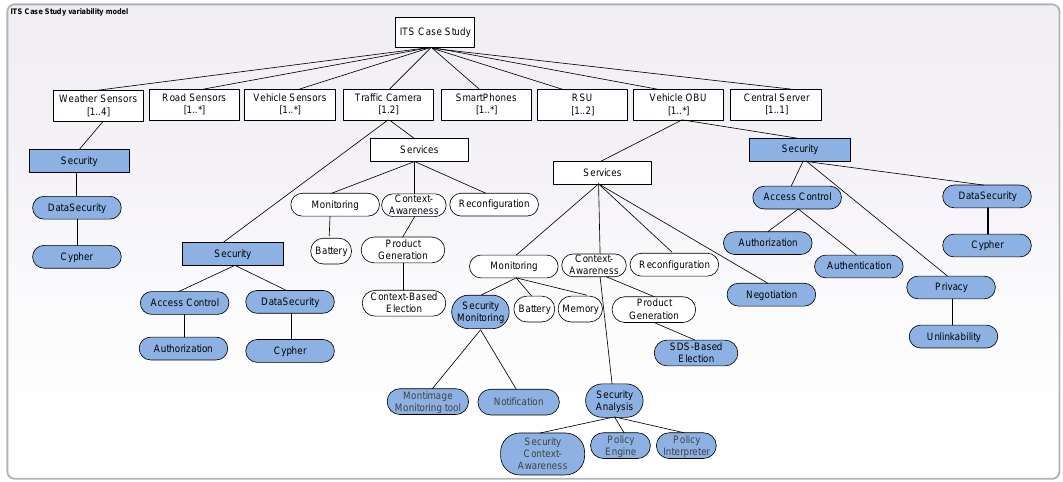
Figure 8. Intelligent transport system (ITS) case study variability